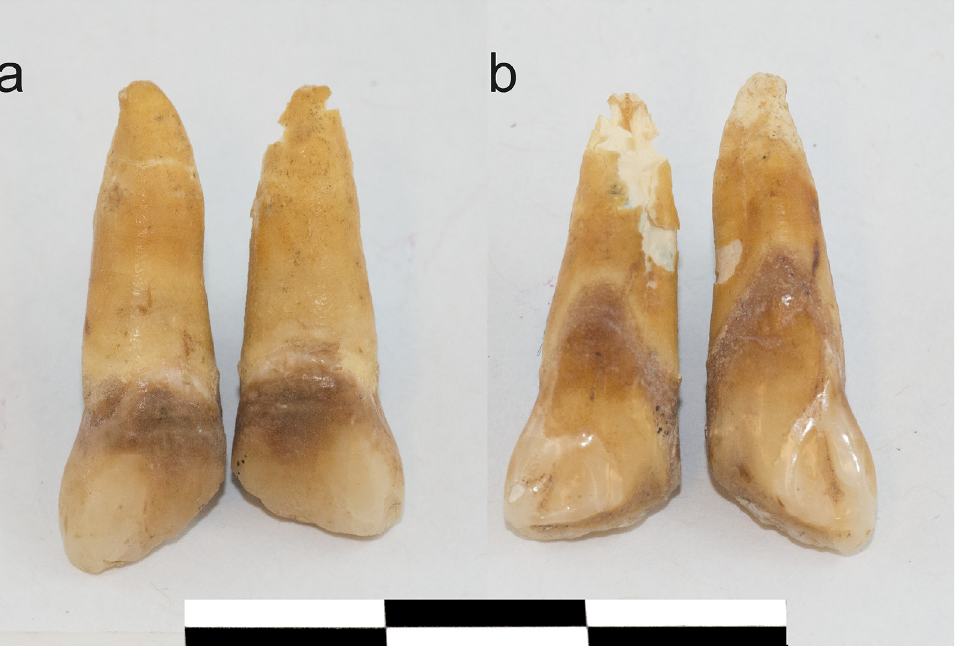
Fig 1. Modified central incisors of the individual E-105. Modified central incisors of the individual E-105 from the OC component, dated to 990 – 800 cal BC: a) labial view; b) lingual view (Photo by W. Hiebert, University of Winnipeg).